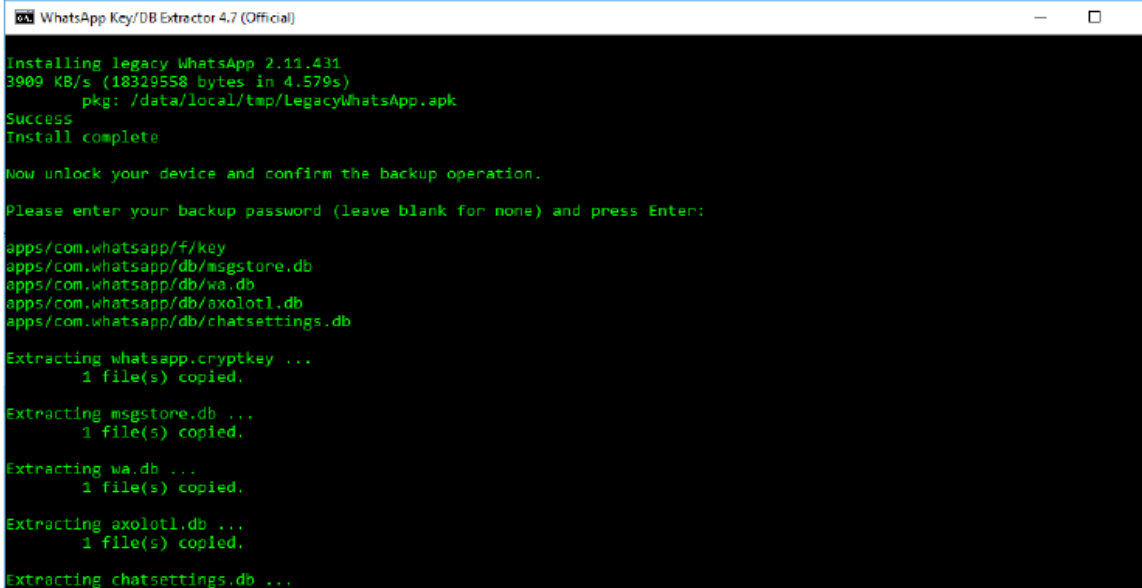
Figure 3. Extraction of msgstore.db, wa.db, and the crypt key